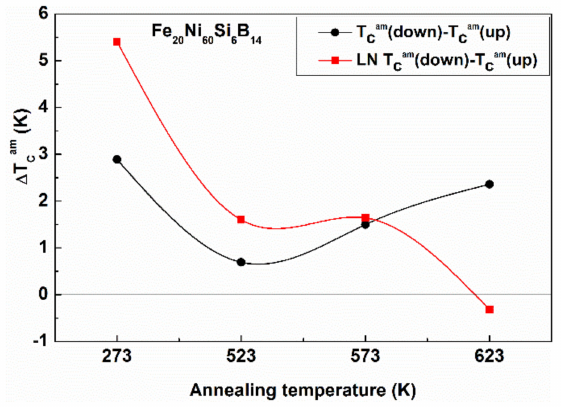
Figure 18. Evolution of the di ff erence in Curie temperature ∆ T Cam in Fe 20 Ni 60 Si 6 B 14 samples after 1 h isothermal heat treatment at various temperatures. One series of samples was immersed into liquid N 2 (77 K) for 20 h before the heat treatment. Adopted from [96], with permission from Springer Nature, 1969.